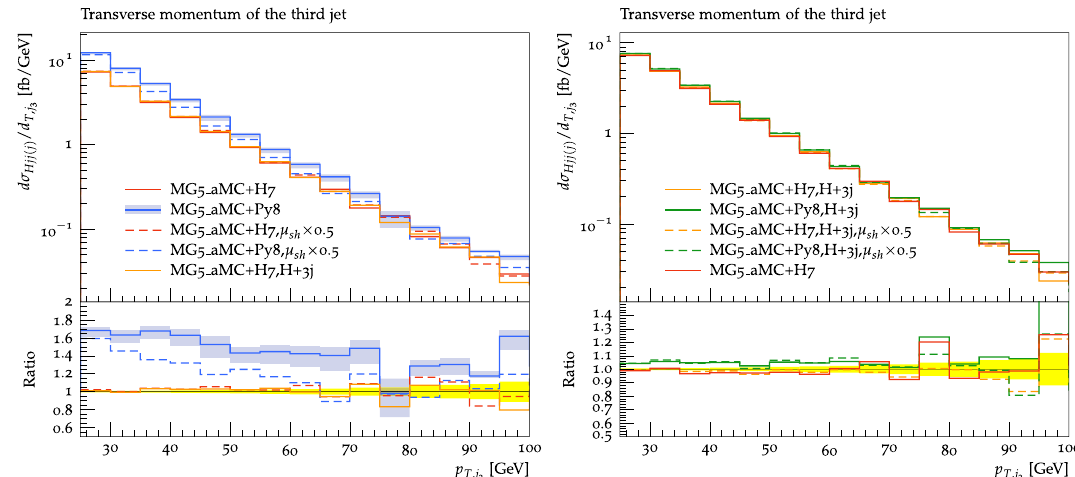
Fig. 4 Transverse momentum distribution of the third jet at NLO + PS accuracy as obtained with MadGraph5_aMC@NLO . Left: predictions for the production of a Higgs boson plus two jets via VBF, with the same colour-code as Fig. 2, together with the prediction for Higgs plus three jets via VBF matched with HERWIG7 (orange). Right: predictions for the production of a Higgs boson plus three jets via VBF, matched